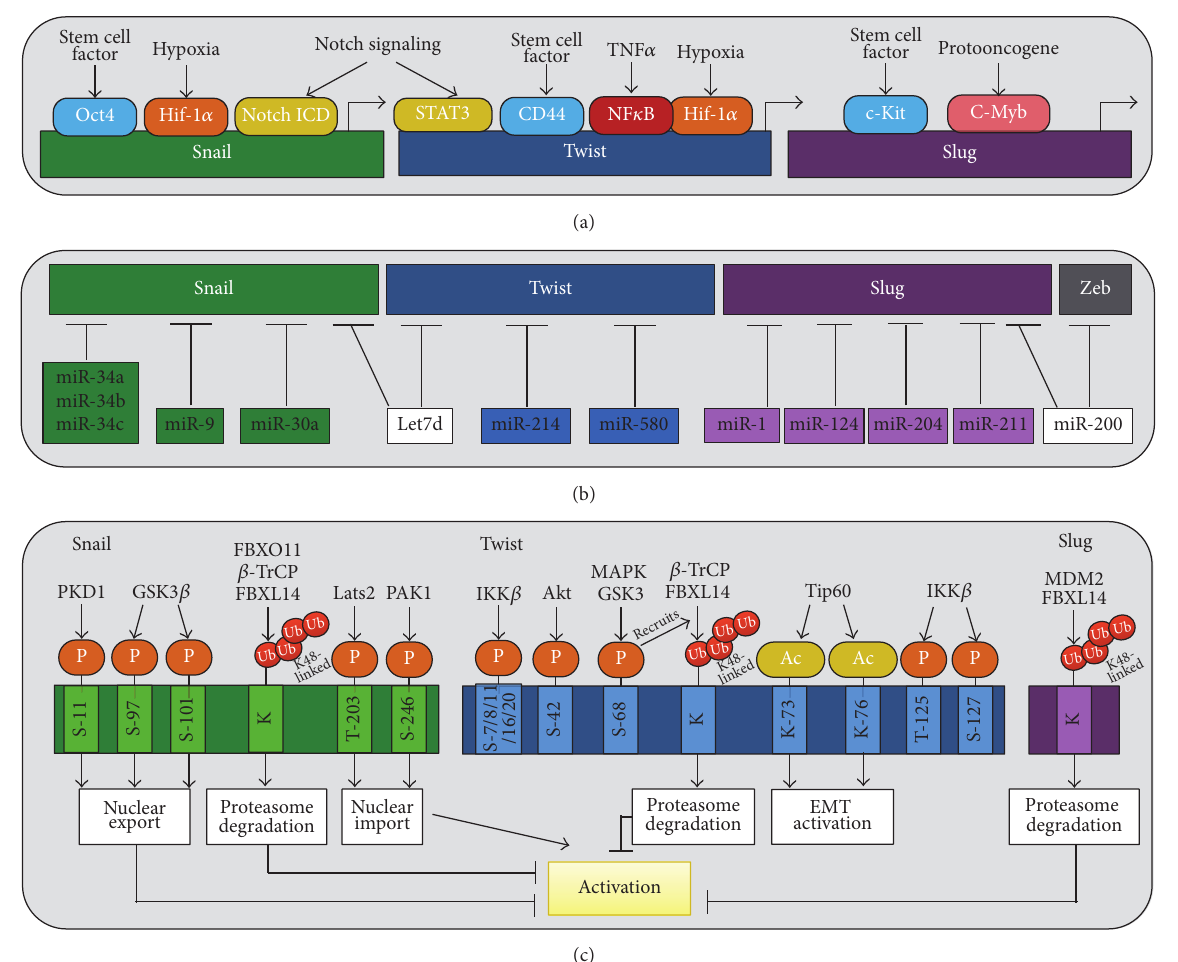
Figure 1: An overview of epithelial-to-mesenchymal transcription factor (EMT-TF) regulation at the (a) transcriptional, (b) translational, or (c) posttranslational